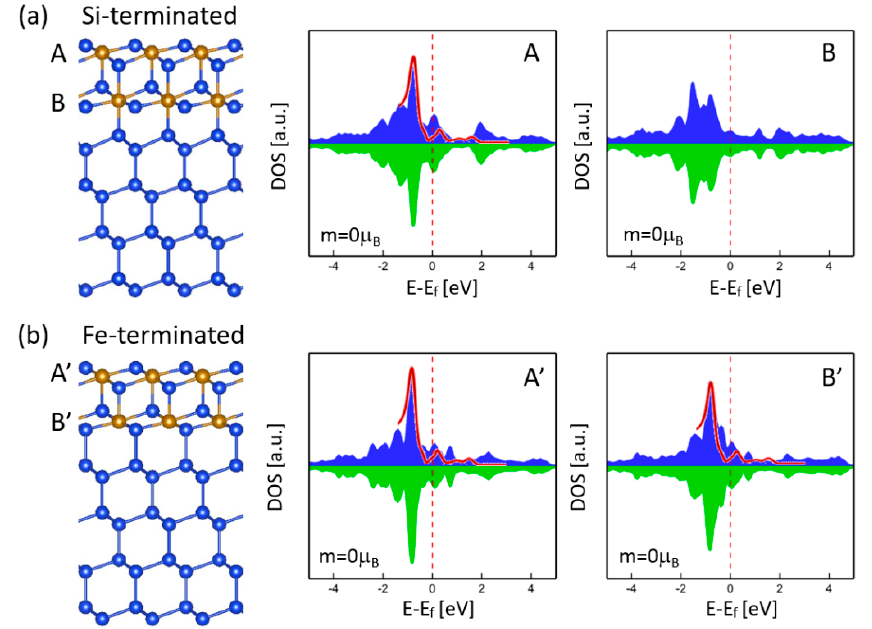
Figure 3. Atomic structures and DOS of Fe atoms in γ -FeSi 2 /Si(111) epitaxial nanoslabs with two types of interface: ( a ) Si-terminated and ( b ) Fe-terminated. The red curve is an experimental DOS reproduced from [17].